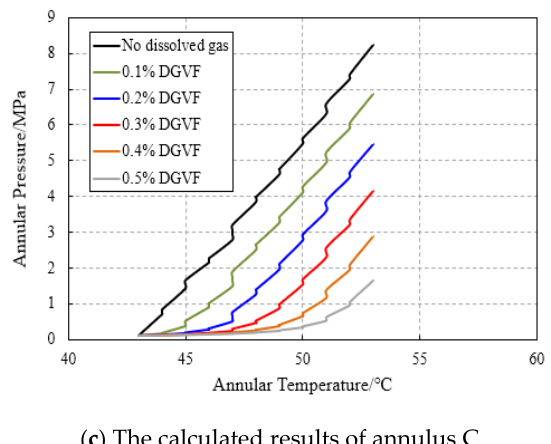
Figure 12. Simulation results under different dissolved gas volume fractions.